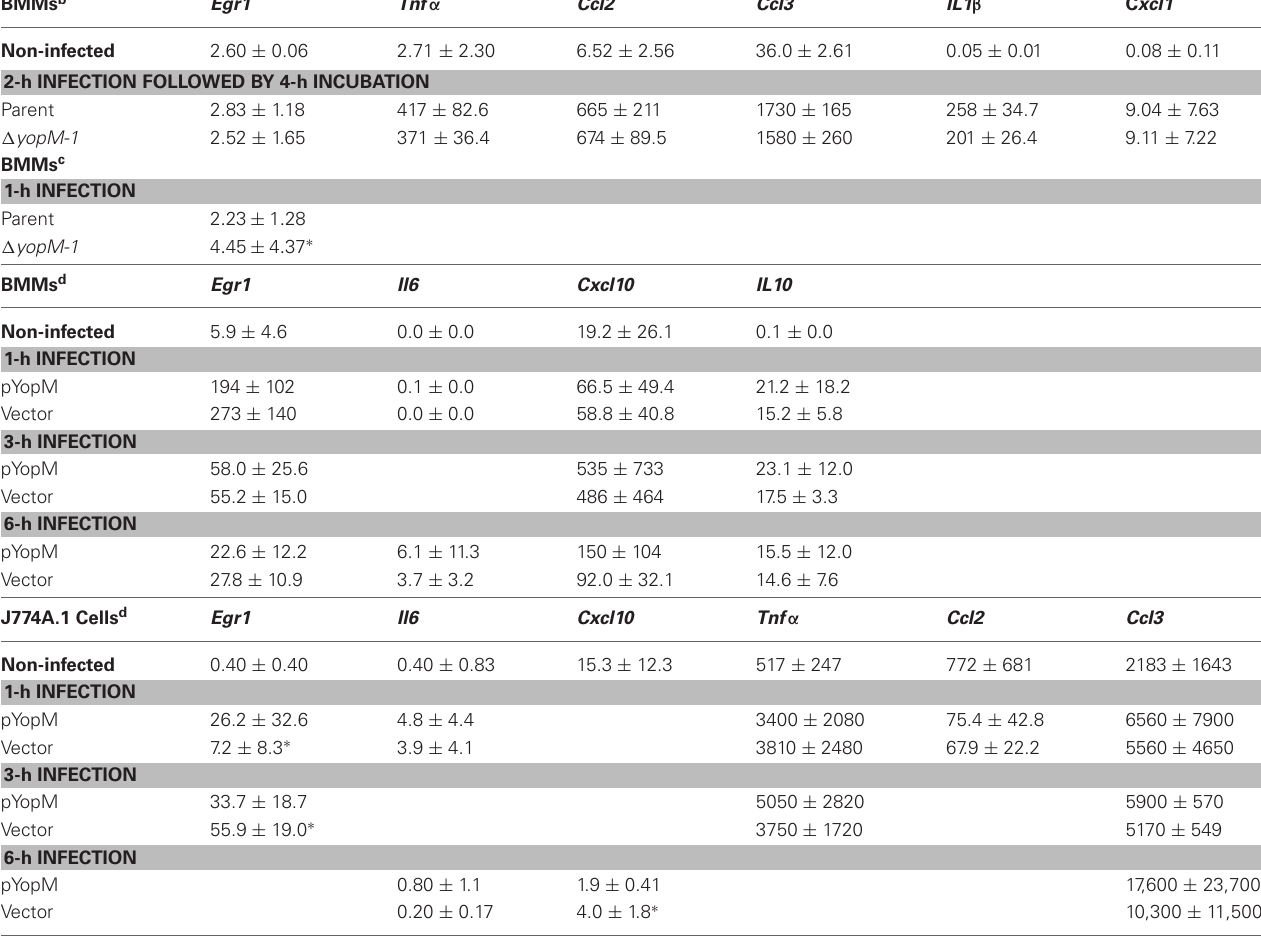
Table 9 | Relative gene expression a in cultured M (cid:2)